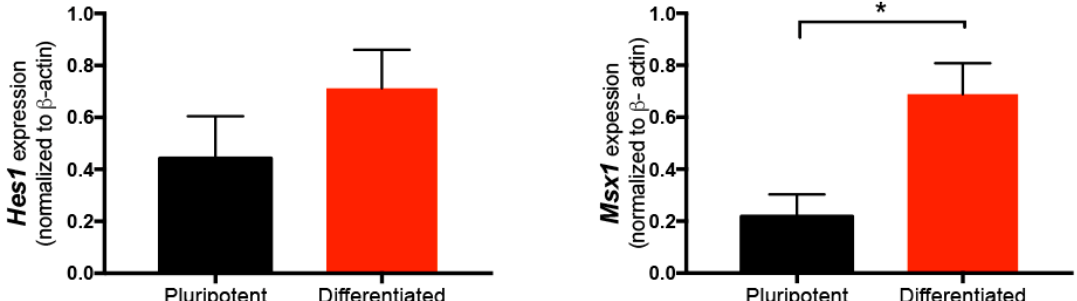
Figure 2. Expression of Hes1 and Msx1 in pluripotent conditions and in cells differentiated to NC. Semiquantitative RT-PCR to measure the endogenous transcripts of these two genes in pluripotent W9.5 cells cultured in 2i/LIF, and after 10 days of differentiation in the PA6 protocol. The expression of Hes1 increased non-significantly. On the other hand, we detected a significant increase in Msx1 expression after NC differentiation. mean ± SEM is represented. Statistical analysis was conducted via one-way analysis of variance (ANOVA) followed by Tukey’s multiple comparison test to establish differences. * p = 0.032.